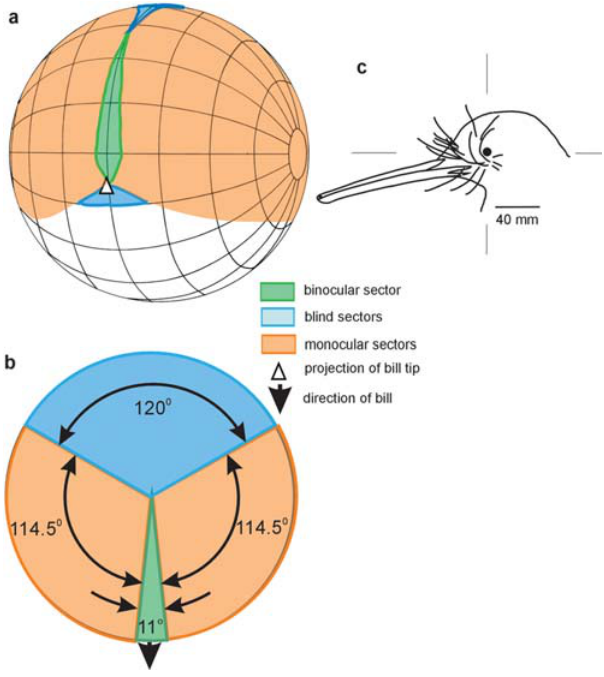
Figure 1. Visual fields of Kiwi. a, Perspective view of an orthographic projection of the binocular field as projected onto the surface of a sphere surrounding the bird’s head. The grid shows conventional latitude and longitude at 20 u intervals and the median sagittal plane of the bird’s head is in the plane of the equator (which is vertical). The head is in the same posture as depicted in ( c ). b, Horizontal section through the visual field in the plane of maximum binocular field width which is the horizontal plane in ( a ) and ( c ). c, Drawing of a side view of a kiwi head, the bill tip projects 20 u below the horizontal as shown in ( a ). Scale bar 40